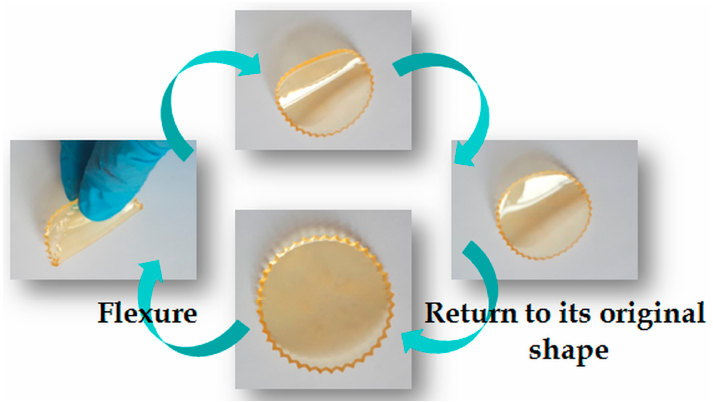
Figure 7. Flexibility of the obtained epoxy/NCs nanocomposites demonstrated by their returning to the initial form.